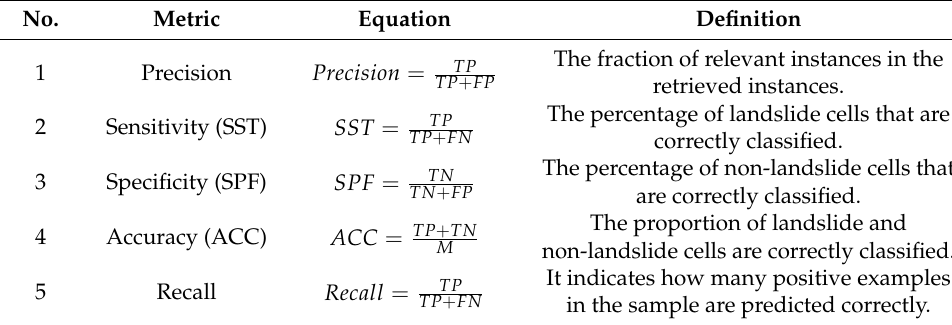
Table 3. Explanation of statistical-index-based